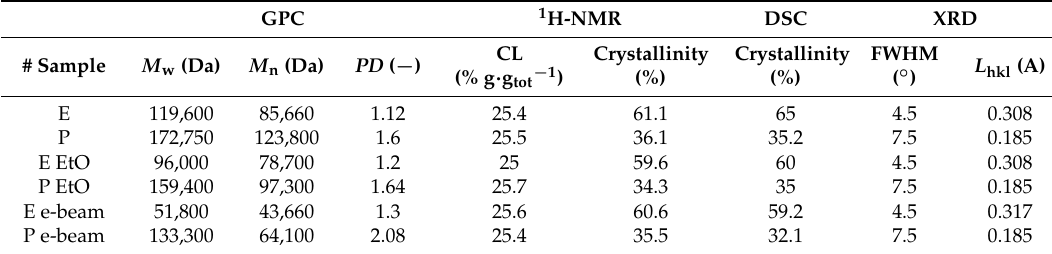
Figure 1. Gel permeation chromatograph (GPC) chromatograms of P (blue line) and E (red line). Picture of the two pristine polymers as removed from the supplier’s packaging. Table 1. Data obtained by GPC, Nuclear Magnetic Resonance ( 1 H-NMR), differential scanning calorimetry (DSC), and X-ray diffraction (XRD) of the polymeric samples.